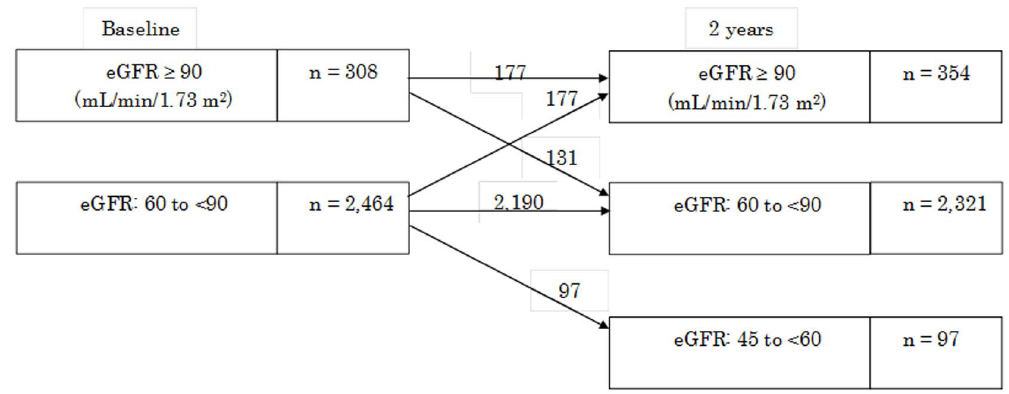
Figure 2. Change in eGFR over 2 years. eGFR was classified from stage 1 to stage 3a according to the CKD stage. Note that eGFR changed over 2